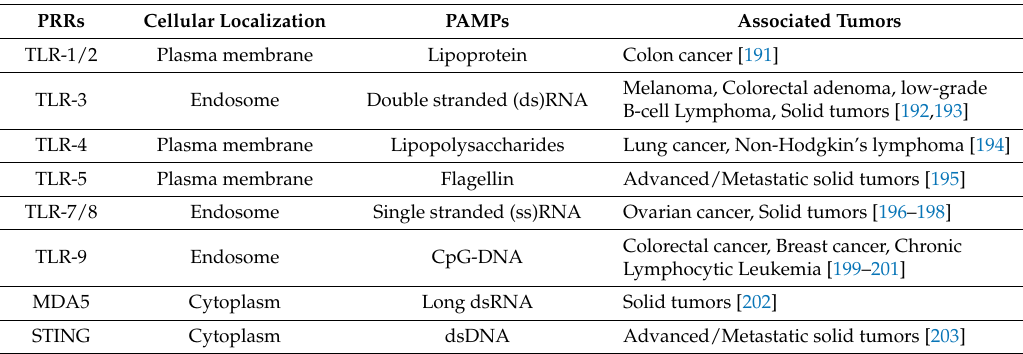
Table 2. Summary of key PRRs and associated human